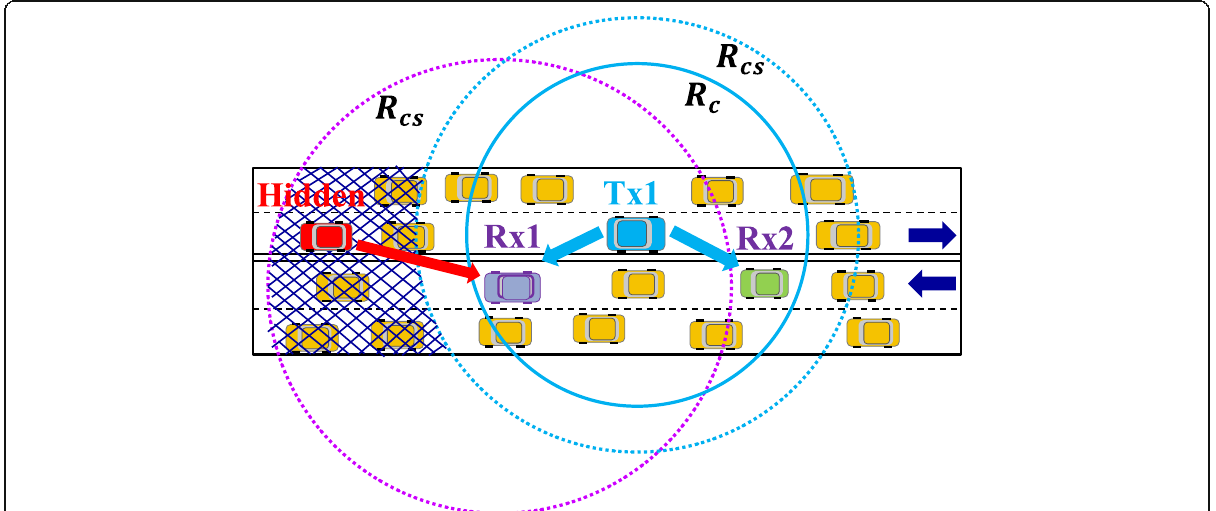
Fig. 1 An example of a hidden terminal problem for the transmitter Tx1 and receiver Rx1 pair (the hidden terminal area is shown by